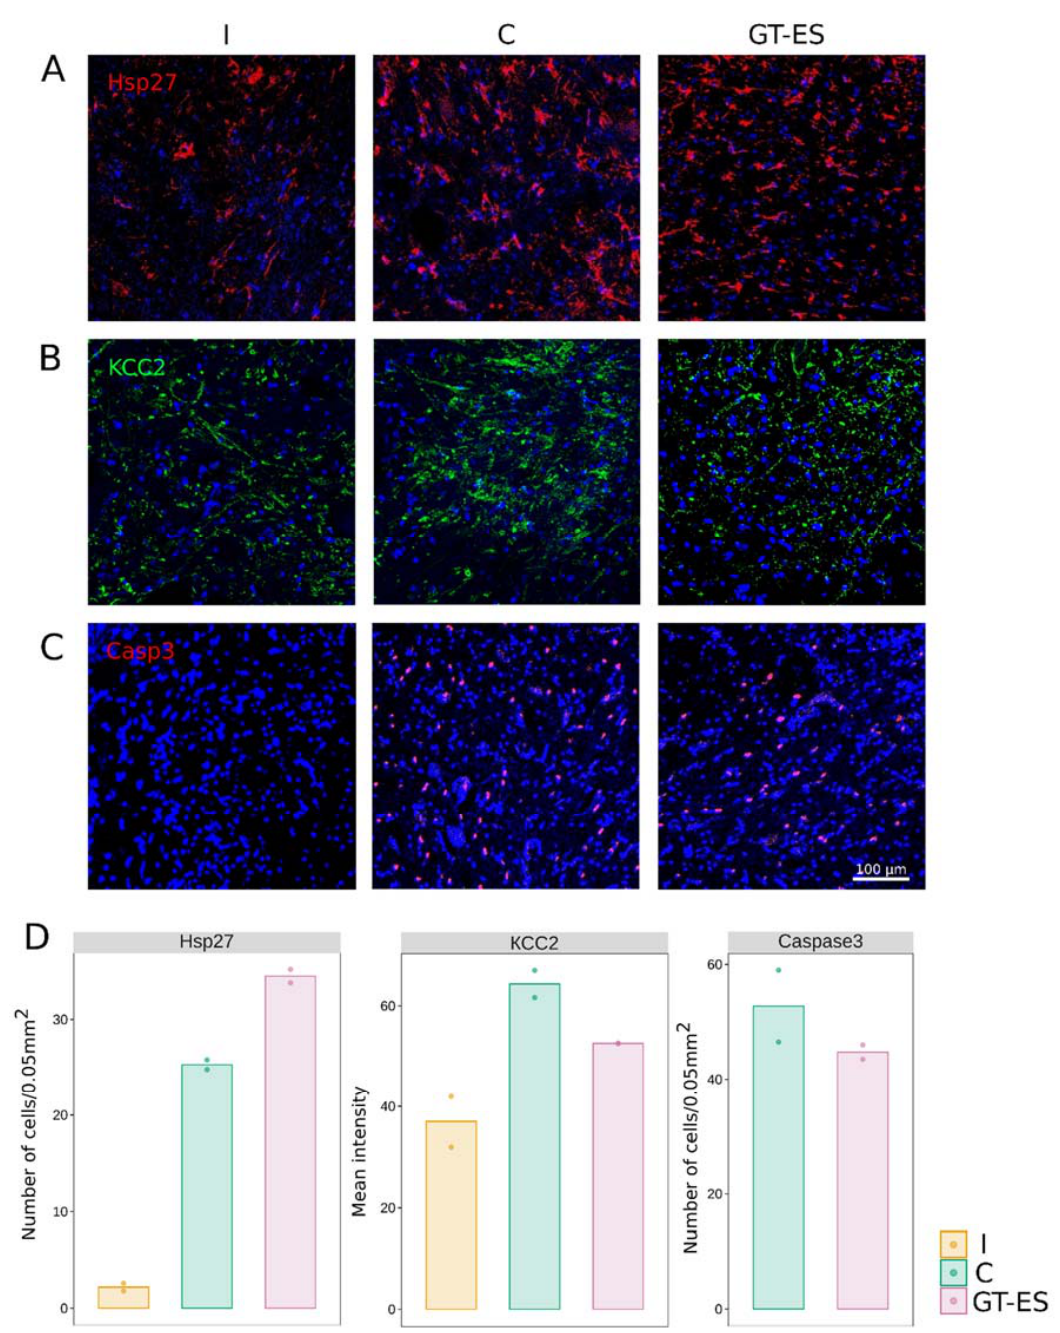
Figure 5. Immunofluorescent analysis of cell stress molecules in spinal cord ventral horns at 60 days after SCI in the CS2 segment. ( A ) Immunoexpression of a heat shock protein of 27 kDa (Hsp27). ( B ) Immunoexpression of a neuron specific K + -Cl − co-transporter (KCC2). ( C ) Immunoexpression of a pro-apoptotic protein Caspase3. Nuclei are counterstained with DAPI (blue). ( D ) KCC2 mean intensity and the number of Hsp27 and cCaspase3-positive cells in intact (I), control (C), and treated (GT-ES) pigs. Caspase3-positive cells in the intact (I) group were not observed. Values averaged within animals are presented as points; bars represent group-wise average values. The average fluorescence intensity of Synaptophysin was decreased in C (14.3) and GT ‐ ES (31.8) experimental groups in comparison to intact animals (37.8). However, the higher level of